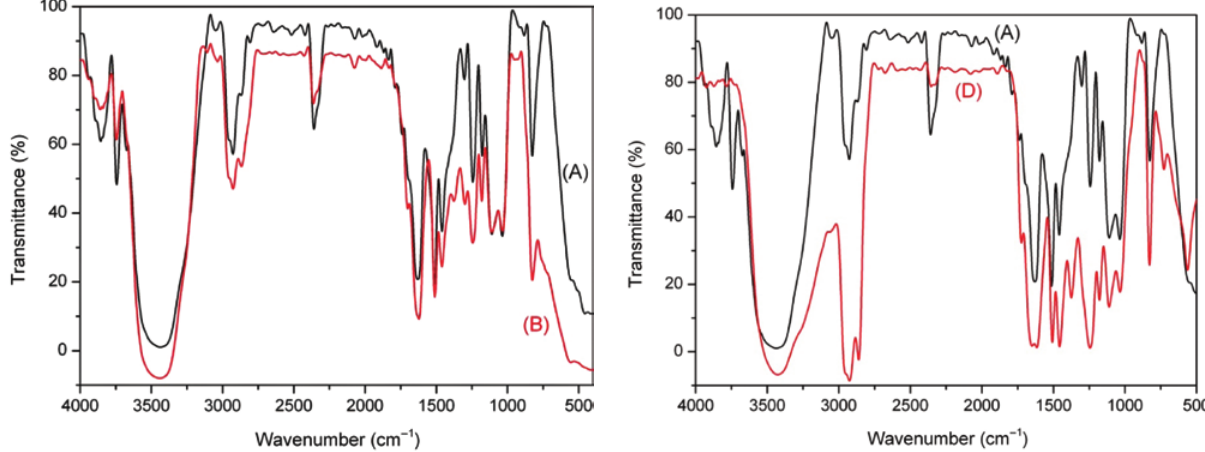
Figure 5: The IR spectrum of the epoxy resin before (A) and after 10 min of neutron irradiation (B) in the TRR reactor core.